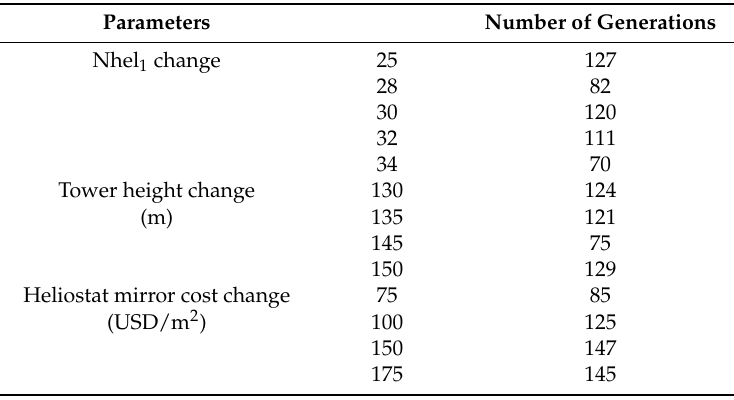
Table 3. Number of generations taken to reach the optimum result.